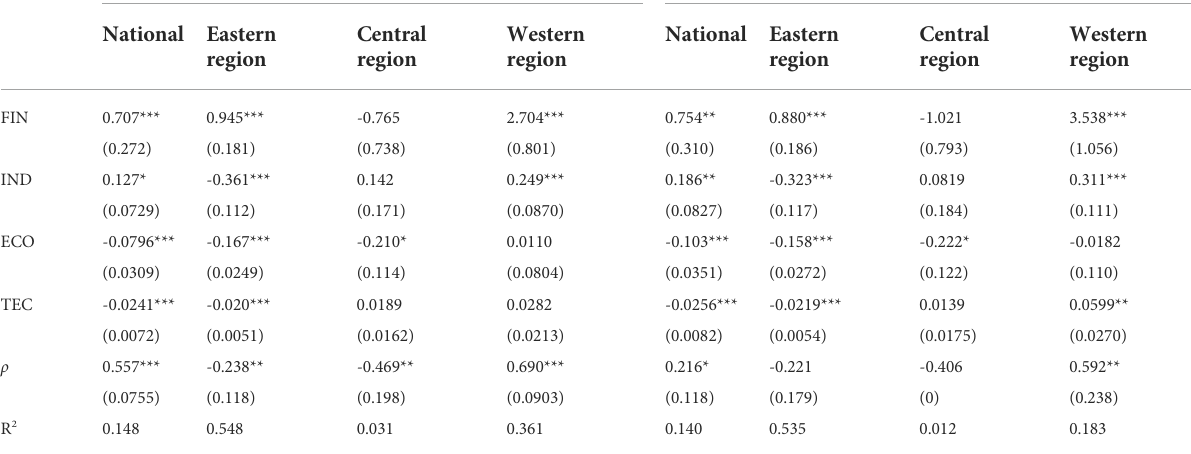
TABLE 7 Regression results of SAR model. Variable Proximity